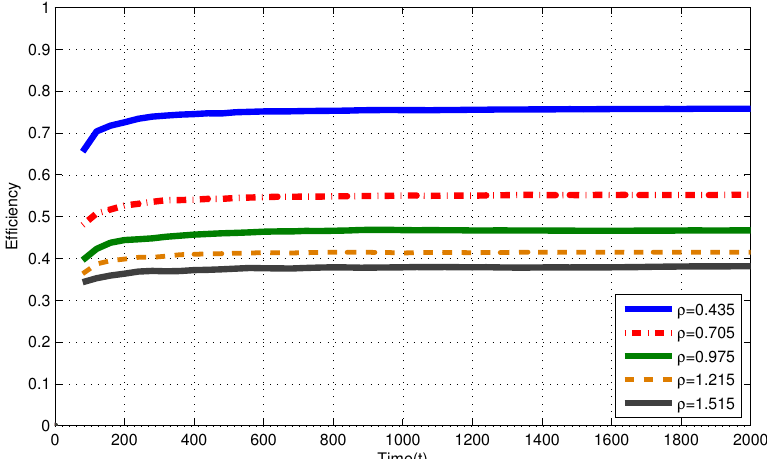
Figure 2. Efficiency of the myopic policy (MP) for i.i.d. EH processes under infinite capacity battery assumption.